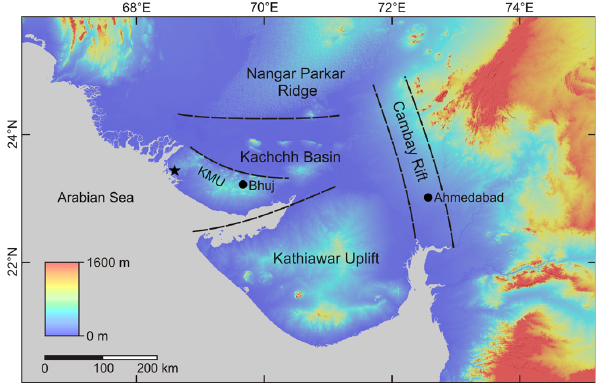
Fig. 1. Digital elevation model of northwestern India (Jarvis et al., 2008) showing the main structural geological elements of the Kachchh Basin. The black asterisk locates the studied outcrop at Bermoti (23 ◦ 27 0 45 00 N, 68 ◦ 36 0 07 00 E) on the Kachchh Mainland Uplift